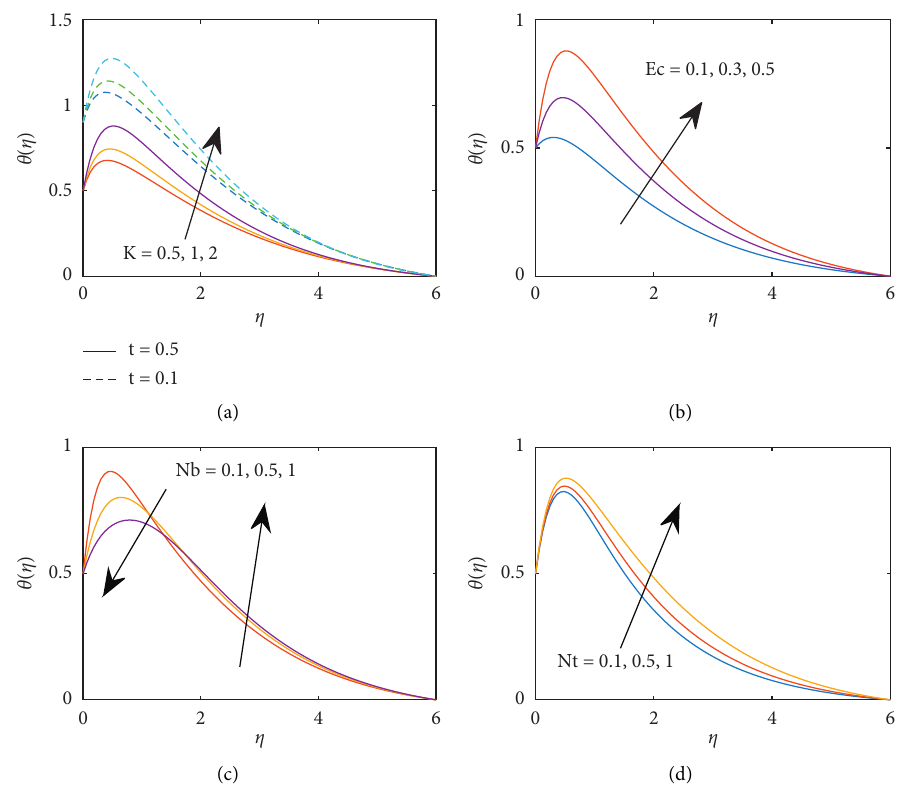
Figure 13: Impact of (a) K